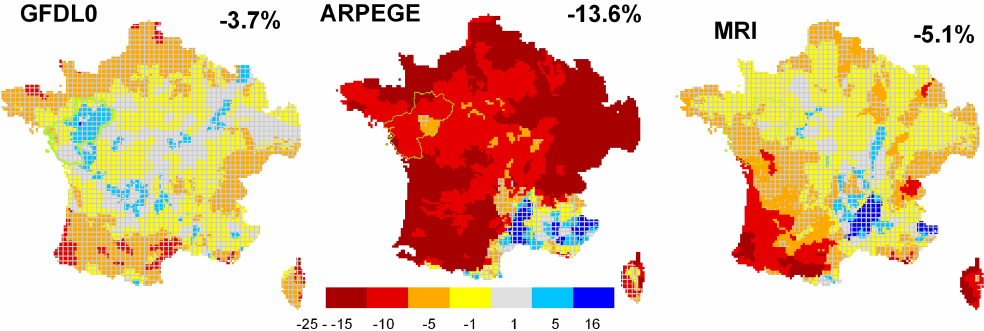
Figure 12. Evolution of annual average precipitation (in %) for the period 2045–2065 compared to 1970–2000 for the three climate projec- tions. Changes that are not significant at the 95% level are hatched.